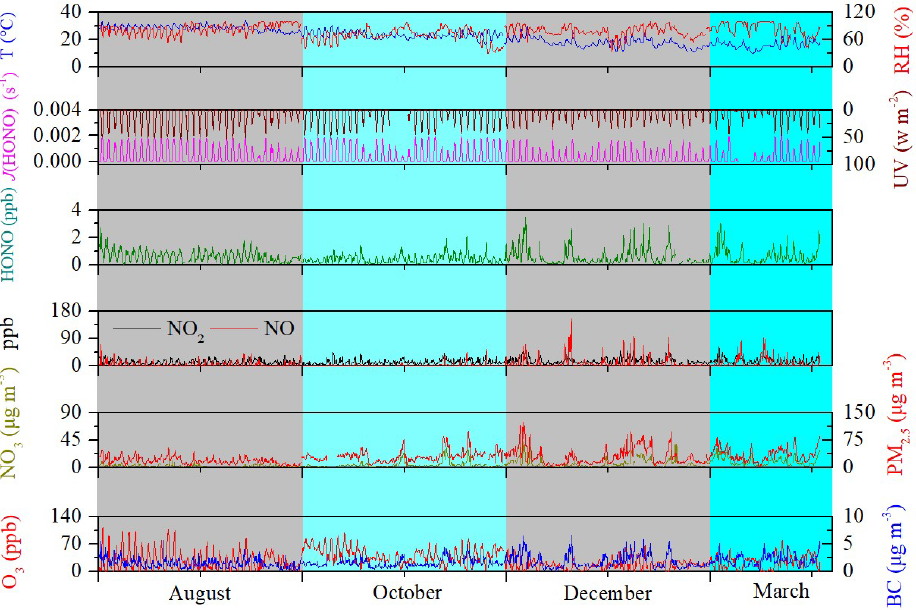
− , PM 2 . 5 , O 3 , and black car- 3